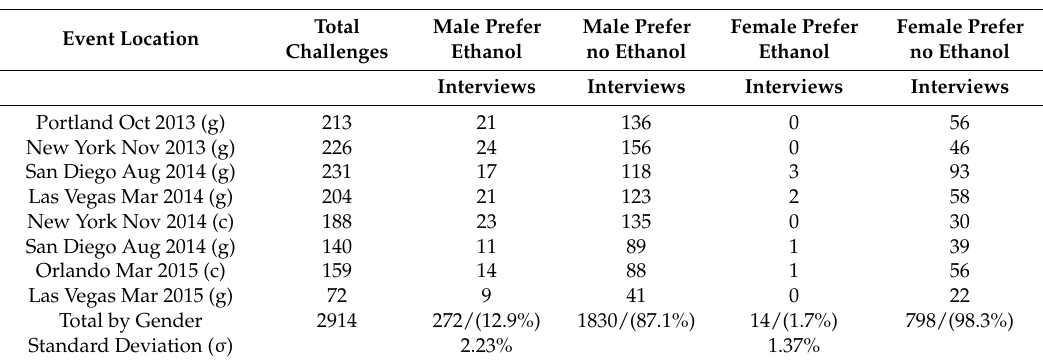
Consumer Test I: Male vs. Female Preferences for Ethanol